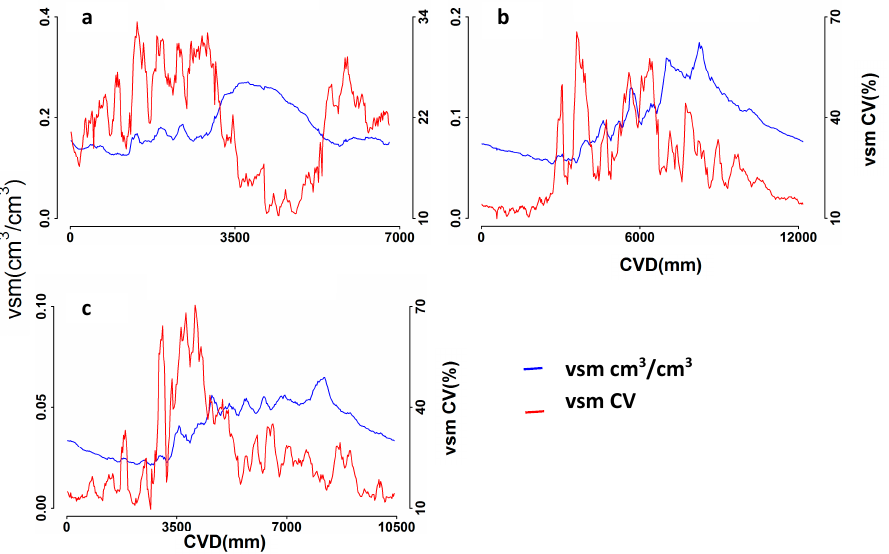
Figure 8. Average (2003–2015) vsm superimposed with its interannual CV (%) and standard error bars for ( a ) site #35 in Ethiopia), ( b ) #5 in South Sudan, and ( c ) #91 in Tanzania. Note differences in scaling of axes.